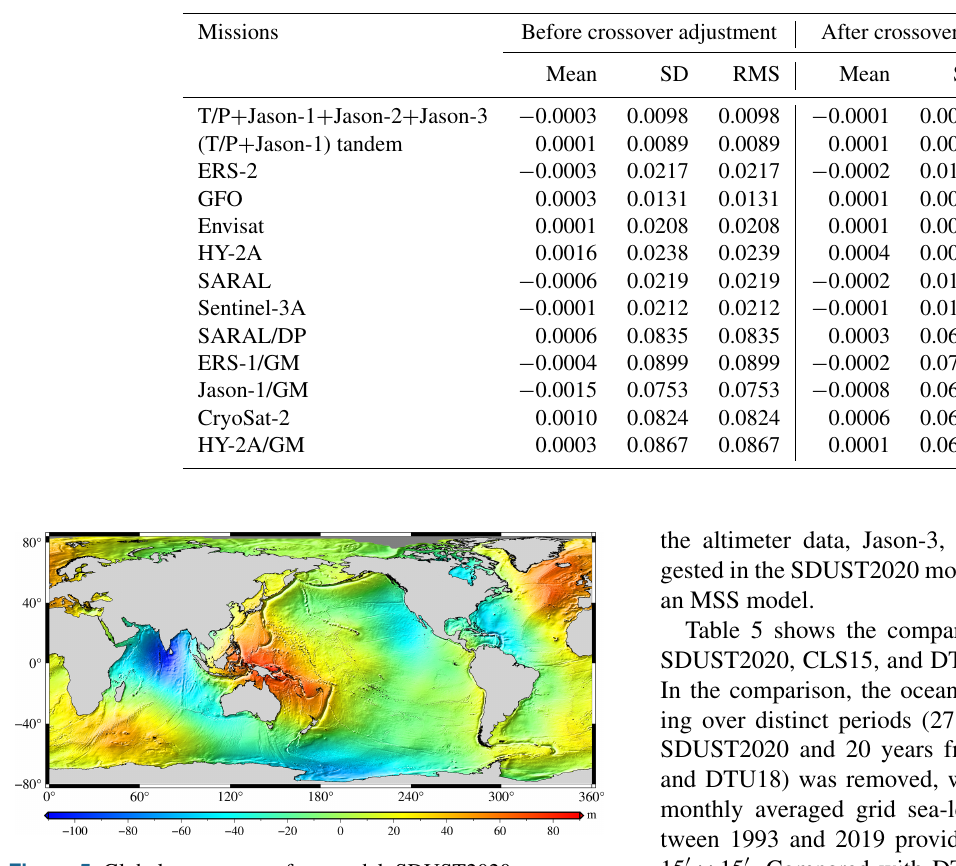
Figure 5. Global mean sea surface model,